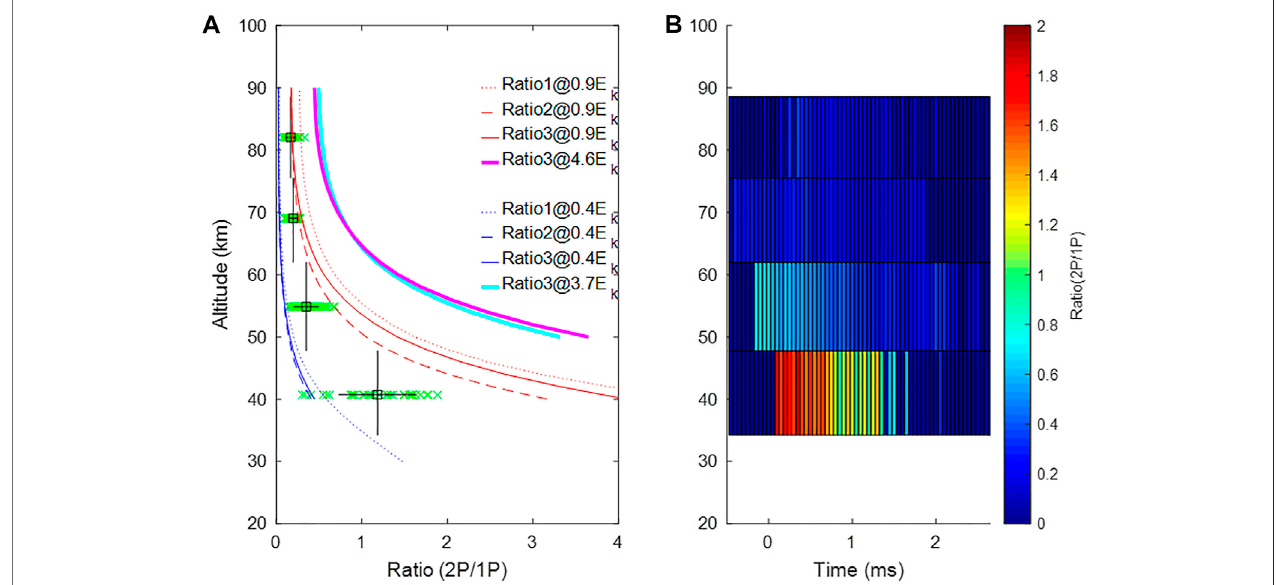
FIGURE 7 | The carrot sprite event at 04:36:16.235 (UT) on July 11, 2010: (A) the AP-measured ratio 2P/1P with predicted emission ratios of Ratio 1 ( r CB ) , Ratio 2 ( R CB ) , and Ratio 3 ( R p CB ) at ambient electric fi elds of 0.4 E k and 0.9 E k . The thick cyan and magenta lines represent the predicted 2P/1P ratio in sprite streamer simulations with streamer head electric fi elds of 3.7 E k and 4.6 E k under ambient electric fi elds of 0.4 E k and 0.9 E k , respectively. (B) the diagram of AP-measured ratios indicated by colors in altitude and